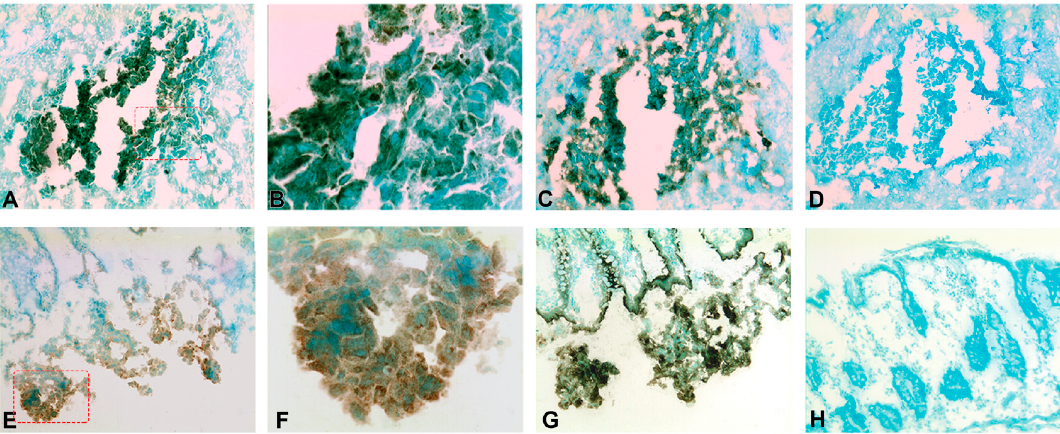
Figure 6. Immunoperoxidase staining of frozen sections of primary colon cancer tissue. ( A ) Anti-CXCL14 staining of primary CC tissue, original magnification ×100. ( B ) Higher magnification of indicated area in ( A ), ×400. ( C ) Anti-CEA staining of primary CC tissue, original magnification X100. ( D ) Negative control of a primary CC tissue, original magnification ×100. ( E ) Anti-CXCL16 staining of primary CC tissue, original magnification ×100. ( F ) Higher magnification of indicated area in ( E ), ×400. ( G ) Anti-CEA staining of primary CC tissue, original magnification ×400. ( H ) Anti-CXCL16 staining of normal colon tissue, original magnification ×100. Note that ( A ), ( C ) and ( D ), and ( E ) and ( G ) are consecutive sections.